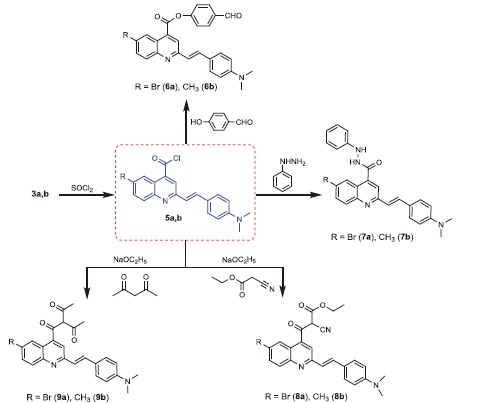
Synthesis of compounds 5a,b–9a,b.